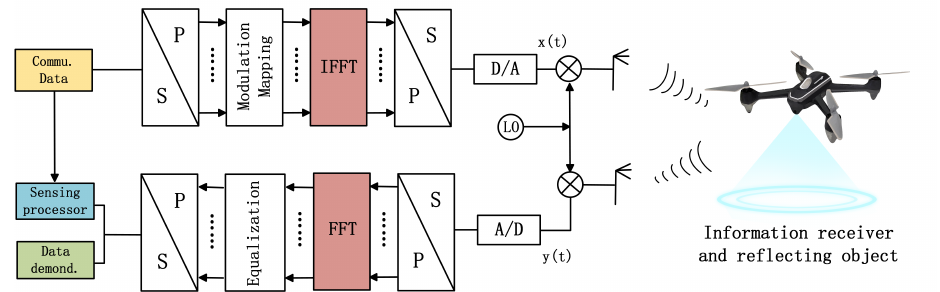
Figure 2. ISAC system structure based on OFDM